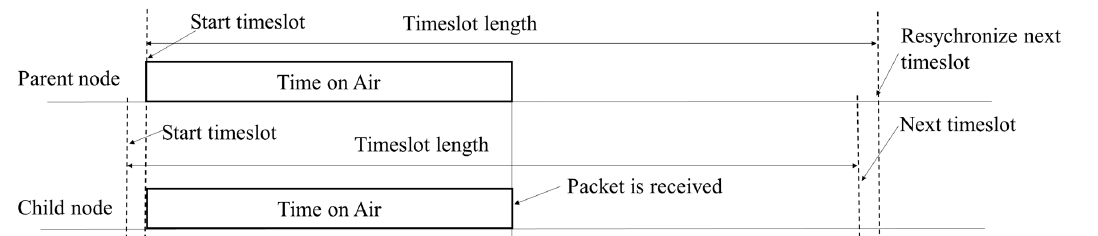
Figure 12. Removing an NCP cycle from the data transmission structure after receiving the